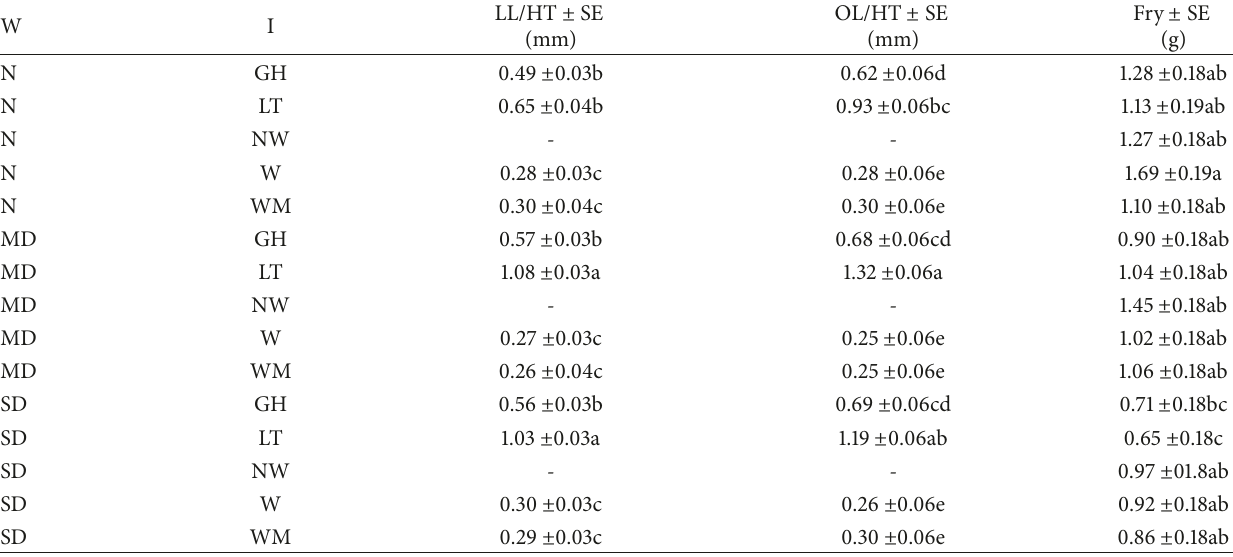
Table 7: Least square means and standard errors of three response variables caused by various inoculations under three different watering